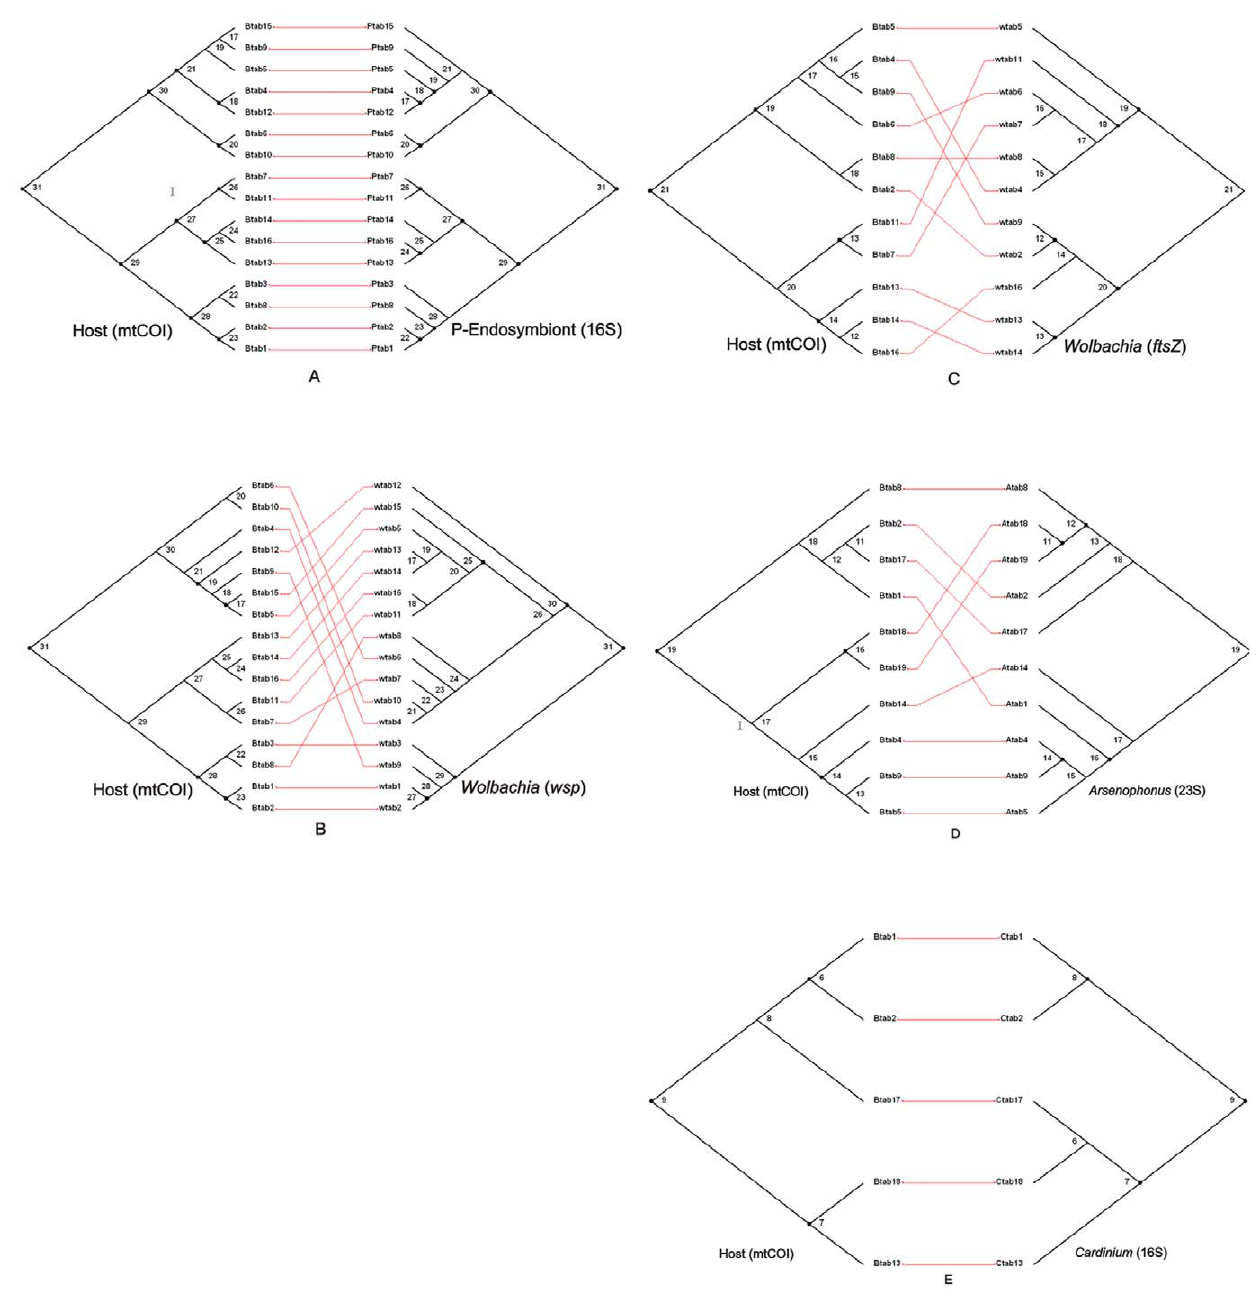
Figure 4. Comparisons of B.tabaci cryptic species and endosymbionts ML phylogenies. Black dots show cospeciation points. A. Host B. tabaci mtCOI versus P-endosymbiont, P. aleyrodidarum 16S rRNA gene. B. Host B. tabaci mtCOI versus S-endosymbiont, Wolbachia wsp . C. Host B. tabaci mtCOI versus S-endosymbiont, Wolbachia ftsZ genes. D. Host B. tabaci mtCOI versus S-endosymbionts, Arsenophonus 23S rRNA gene. E. Host B. tabaci mtCOI versus S-endosymbionts, Cardinium 16S rRNA gene.